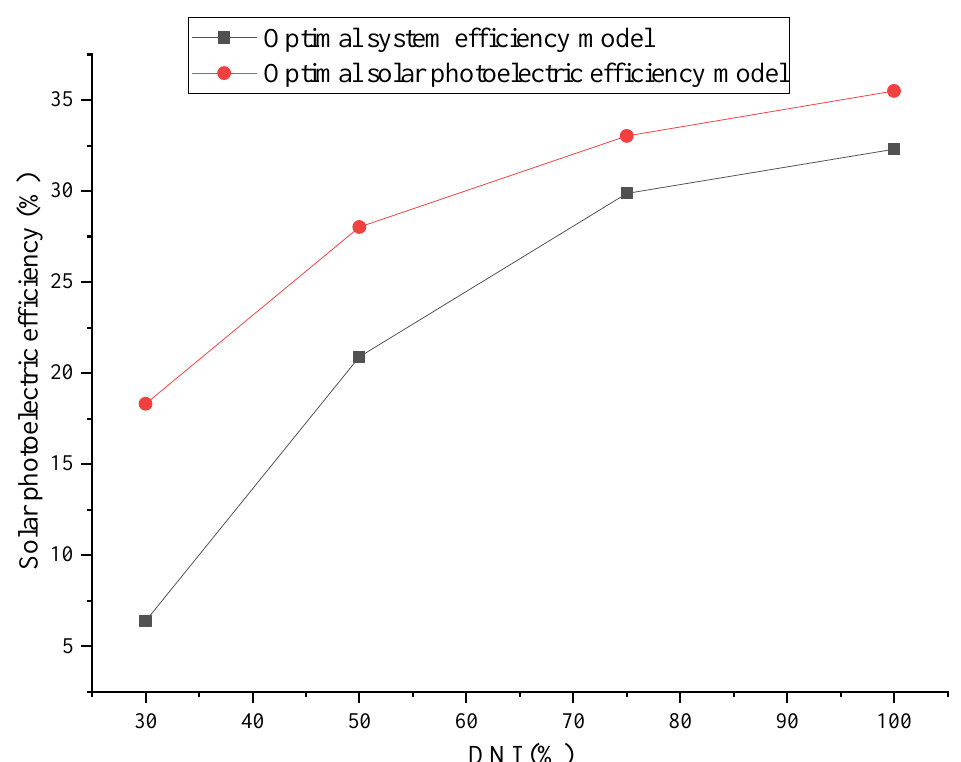
Figure 7. Trend of solar thermoelectric efficiency with DNI reduction for the optimal model of sys- tem/solar photoelectric efficiency under design load.